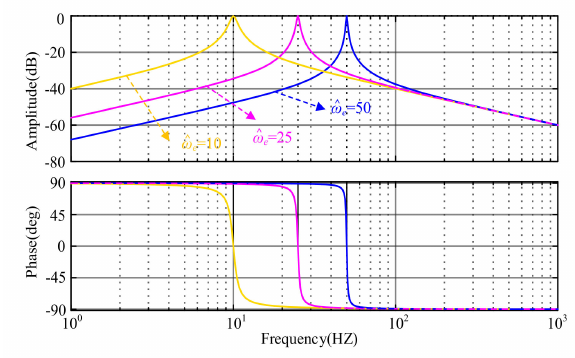
Figure 6. Bode plot of the SFT function when ˆ ω e increases.